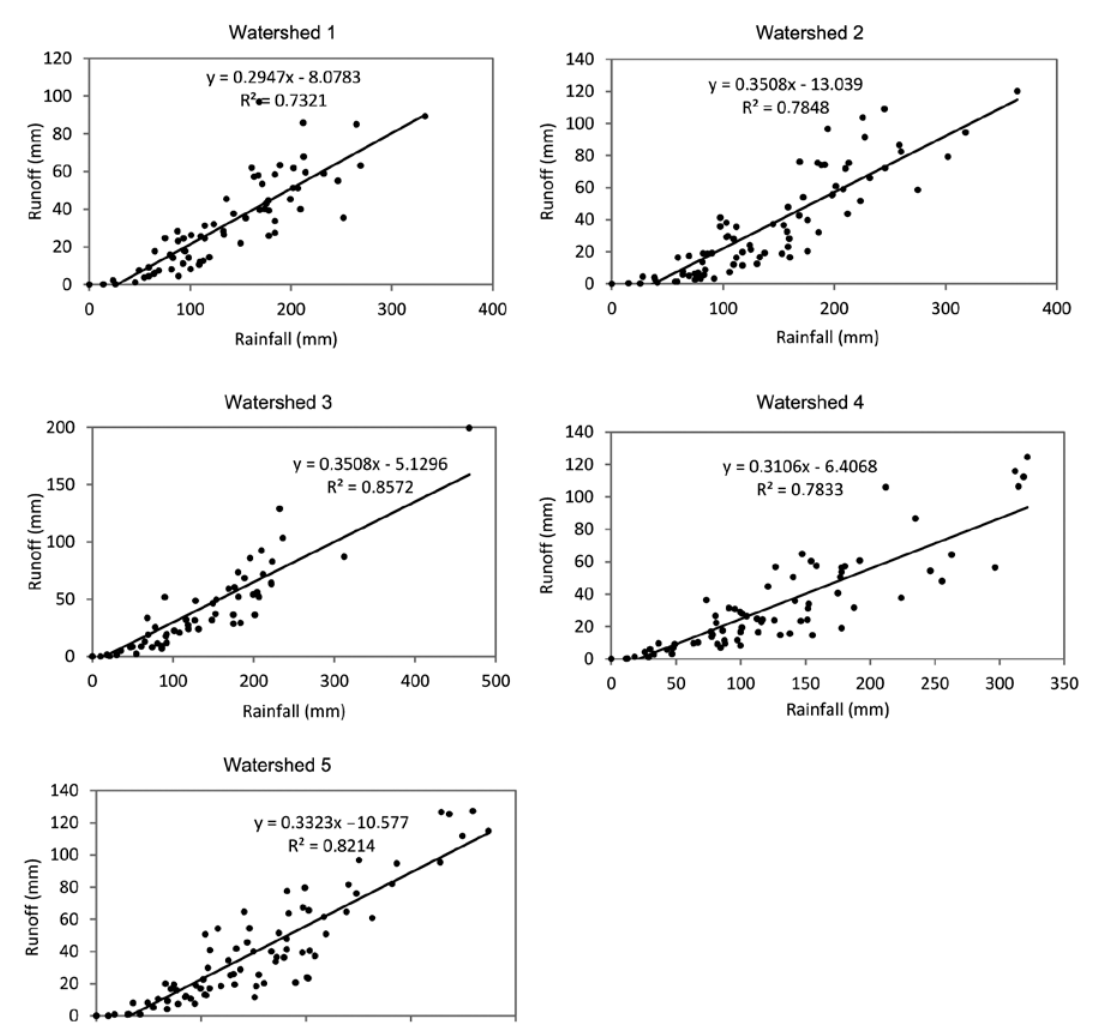
Fig. 8. Estimated monthly rainfall runoff relationship of the study